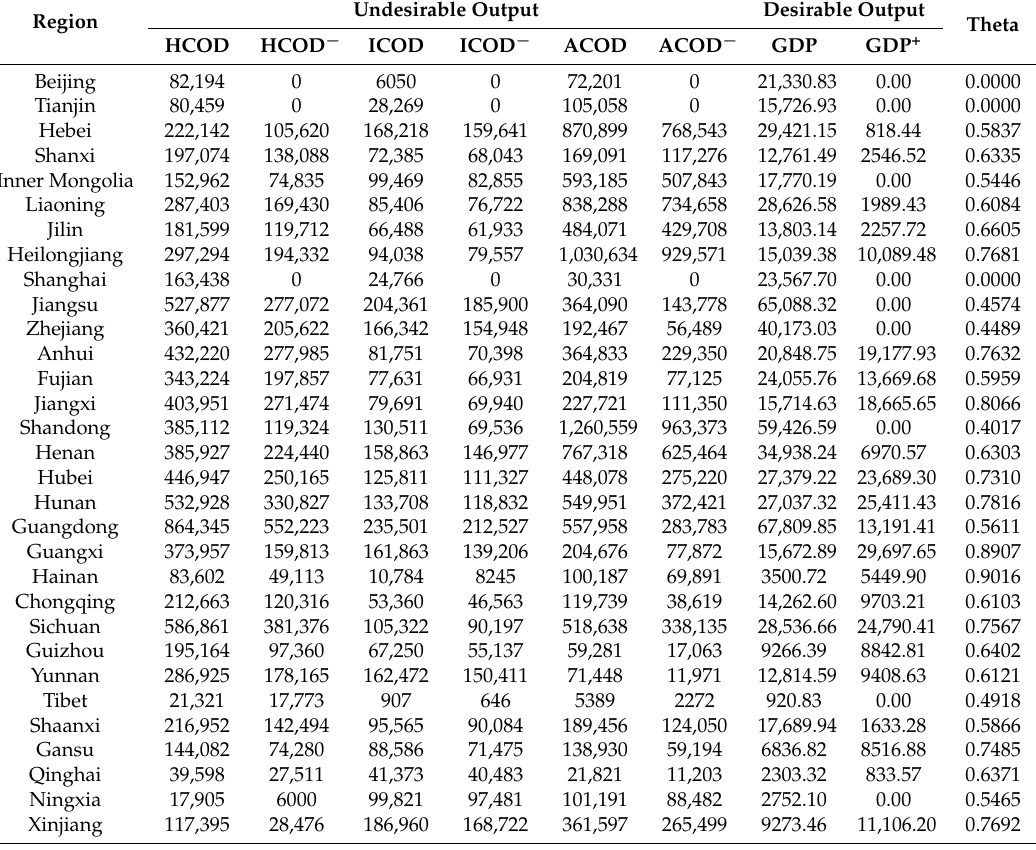
Table A1. The amount of output and its improvement in each region.